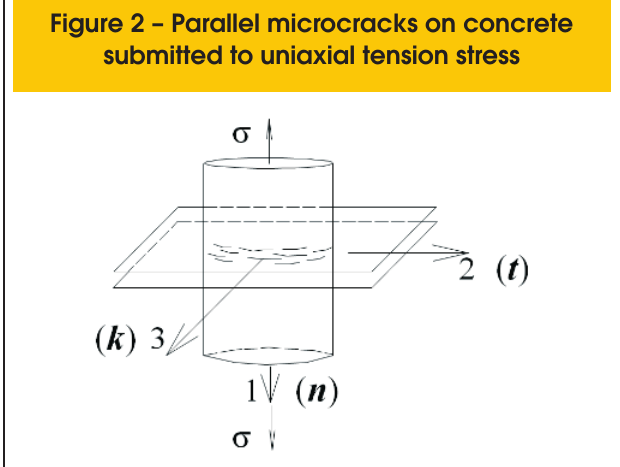
Figure 2 – Parallel microcracks on